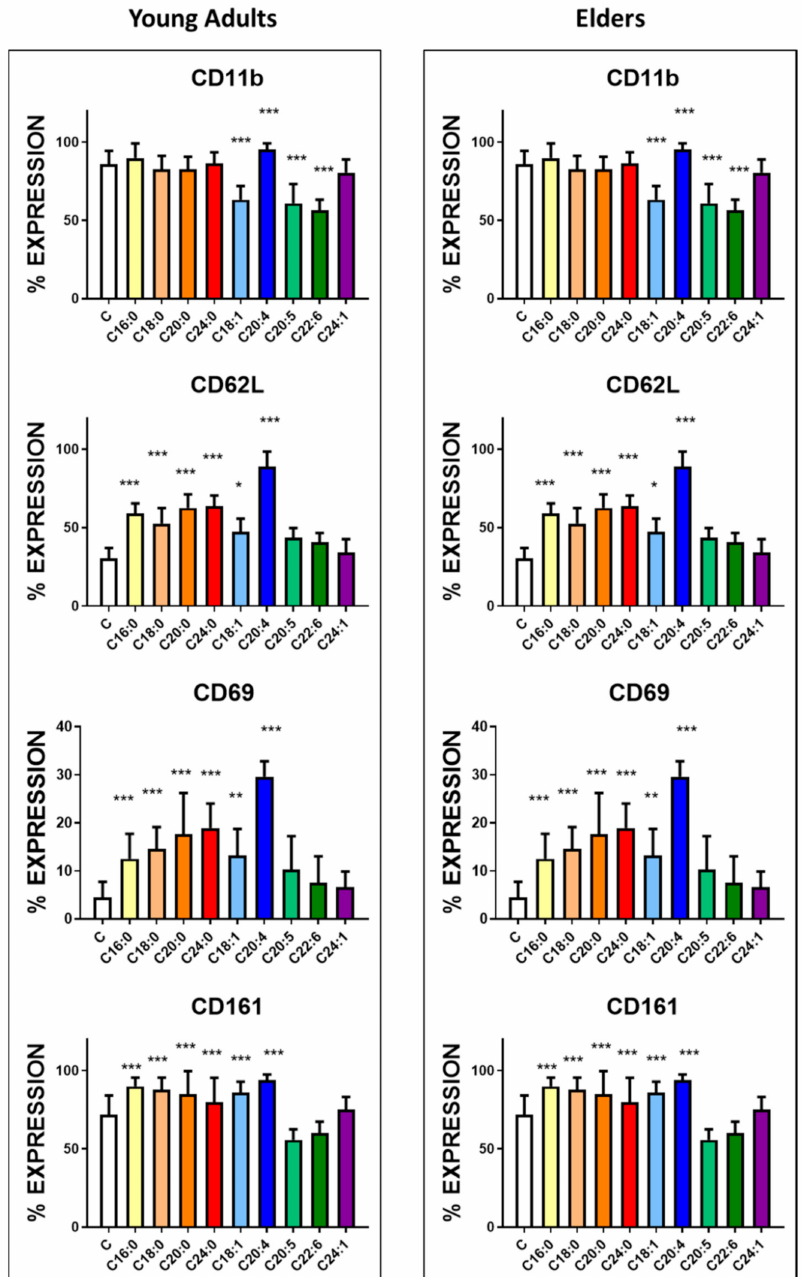
Figure 4. Expression of CD11b, CD62L, CD69 and CD161, markers of cells activation, upon treatment of NK cells with fatty acids. NK cells purified from the blood of the healthy young (23 ± 4 years old) and healthy elder (63 ± 5 years old) volunteers were treated with 10 µ g / mL concentration of the following fatty acids for 24 h. The expression of the receptors was assessed by flow cytometry. The results represent the percentage mean and SD for each group ( n = 30). The treatments were compared by one way ANOVA. Bonferroni significance post-test are represented. * p < 0.01, ** p < 0.001 and *** p < 0.0001. The mean channel fluorescent intensity (MFI) is represented in Supplementary Figure